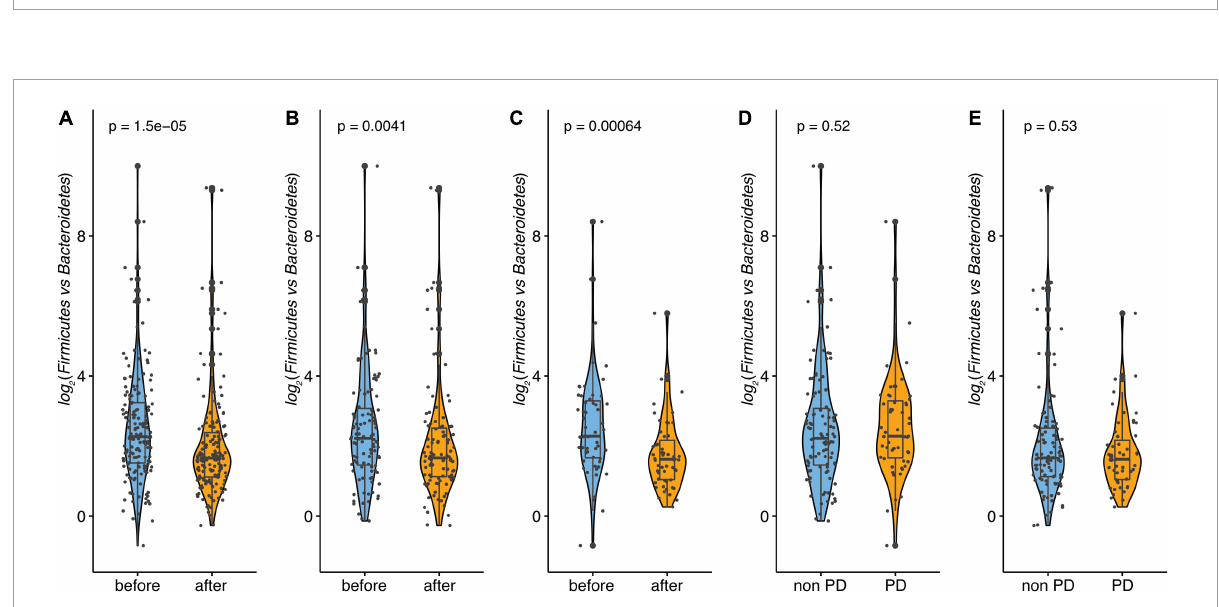
FIGURE5 Firmicutes / Bacteroidetes (F/B) ratio. (A) Ratio F/B across all samples before and after. (B) Ratio F/B for non-pre-diabetic before and after. (C) Ratio F/B for pre-diabetic before and after. (D) Ratio F/B between non-pre-diabetic and pre-diabetic before. (E) Ratio F/B between non-pre-diabetic and pre-diabetic after. Data are presented as individual data points (dots); median and interquartile ranges are shown as boxplots; p-values were estimated using Wilcoxon